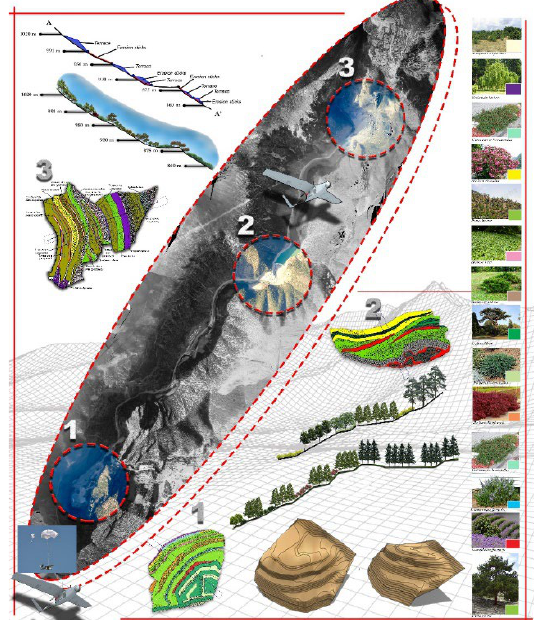
Figure 6 3D models created using UAV images and their use in landscape restoration projects (Adana, Saimbeyli